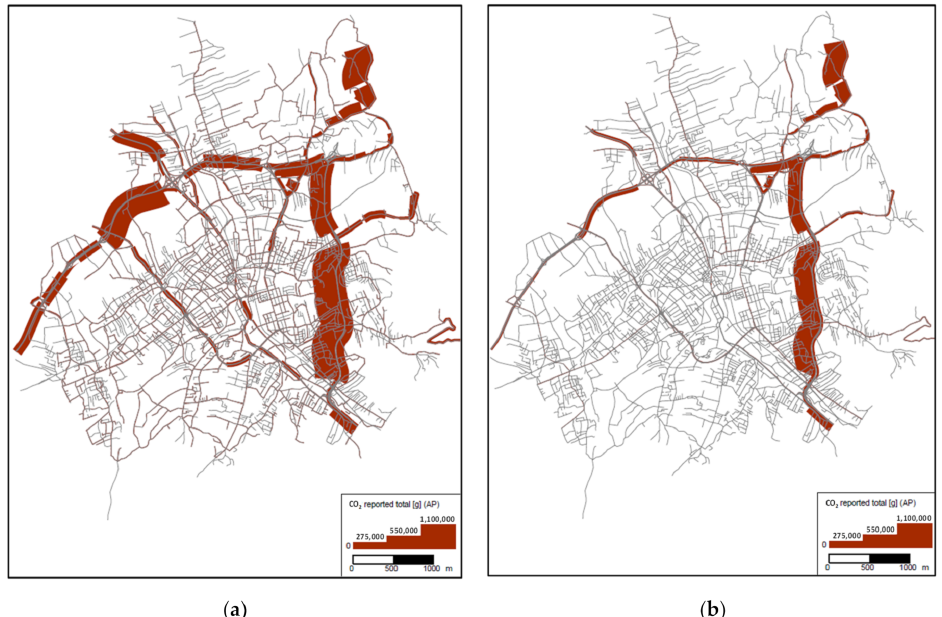
Figure 5. The assessment of CO 2 reported total [g] (measure from Group 1) for scenario W0 and optimal scenario (W4)—analysis for the whole city: ( a ) measure for scenario W0; ( b ) measure for scenario